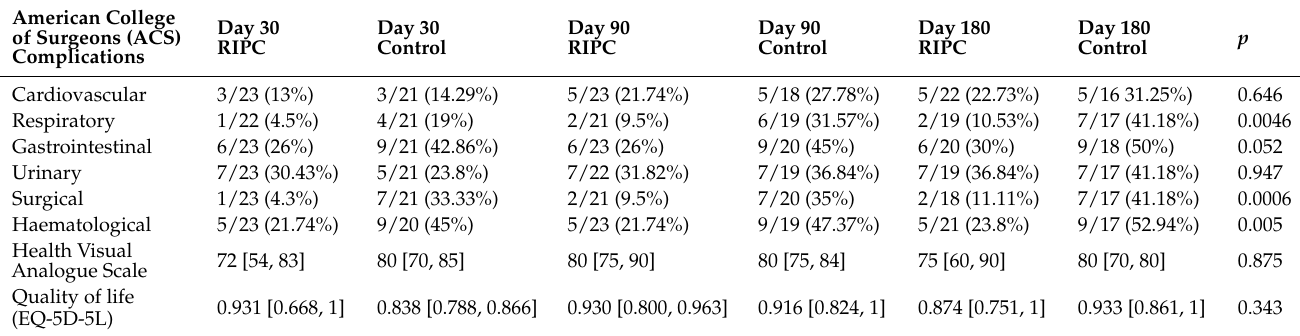
Table 3. Postoperative complications (American College of Surgeons) at 30 days, 90 days and 6 months postoperatively in the remote ischaemic preconditioning (RIPC) and control groups. The p values are derived from Cochran–Mantel–Haenszel tests comparing the development of complications between the intervention and control groups stratified by time (categorical outcomes) or Kruskal–Wallis one way analysis of variance (numerical